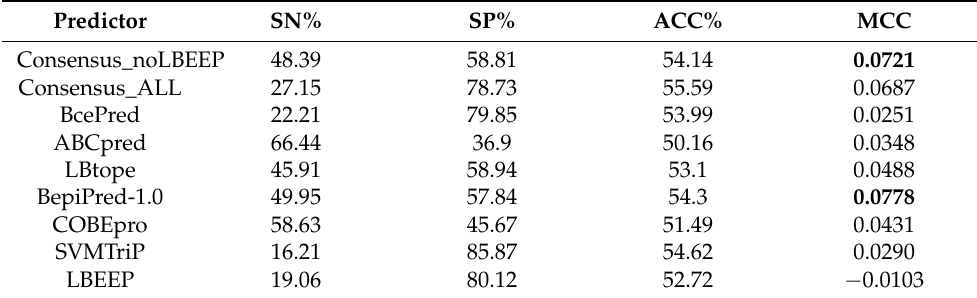
Table 6. Performance of all predictors in “per peptide” mode. The methods are tested against the Consensus_NR (Non_Redundant) data